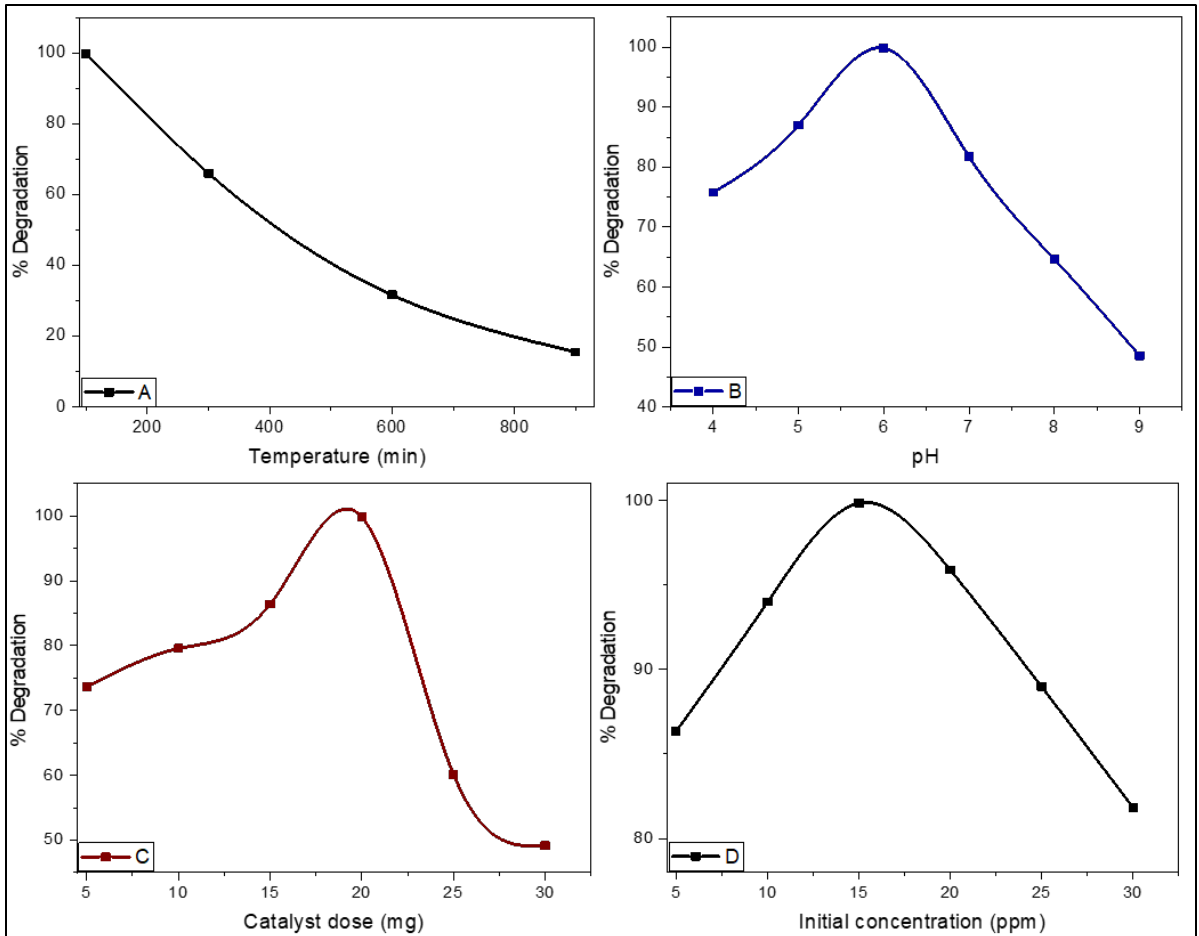
Figure 8. Effect of ( A ) temperature (0 – 900 °C), ( B ) pH (4 – 9); ( C ) catalyst dose (0 – 30 mg), ( D ) initial methyl orange (MO) concentration (0 – 30 ppm) on SnO 2 NP-induced degradation of MO. For each effect to be analyzed, all other variables were optimized and kept constant.